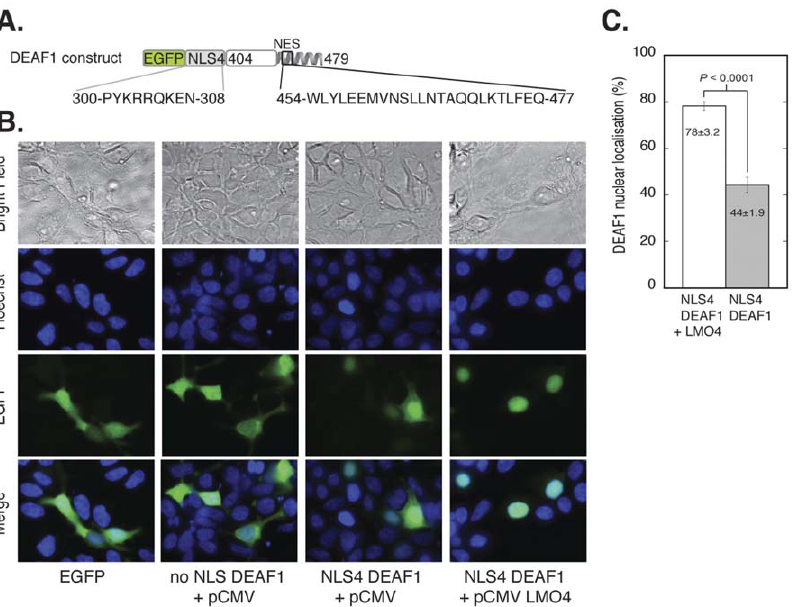
Figure 3. Nuclear localisation of EGFP-NLS4-DEAF1 404–479 in the presence of LMO4. A. DEAF1 construct in pEGFP-C2 that was used for transfection. It has an N-terminal EGFP tag followed by the altered DEAF1 NLS4 and DEAF1 404–479. The NLS4 and NES protein sequences and DEAF1 numbering are shown. B. HEK293 cells grown on cover slips in 6 well plates were transfected with a total of 4 m g of DNA: control pEGFP (panel 1), 2 m g EGFP-DEAF1 404–479 + 2 m g empty pCMV vector (panel 2), 2 m g EGFP-NLS4-DEAF1 404–479 + 2 m g empty pCMV (panel 3) and EGFP-NLS4-DEAF1 404– 479 + 2 m g pCMV LMO4 (panel 4). After 24 h transfection, cells were fixed with paraformaldehyde and nuclei stained with Hoechst dye. Cells were imaged for EGFP fluorescence (green) and nuclear staining (blue) by fluorescence microscopy. C. Quantification of A. The two-dimensional areas of n =8 fields of view were measured for % nuclear localisation of EGFP-NLS4-DEAF1 404–479 in the presence and absence of LMO4. Difference is statistically significant as p , 0.05.